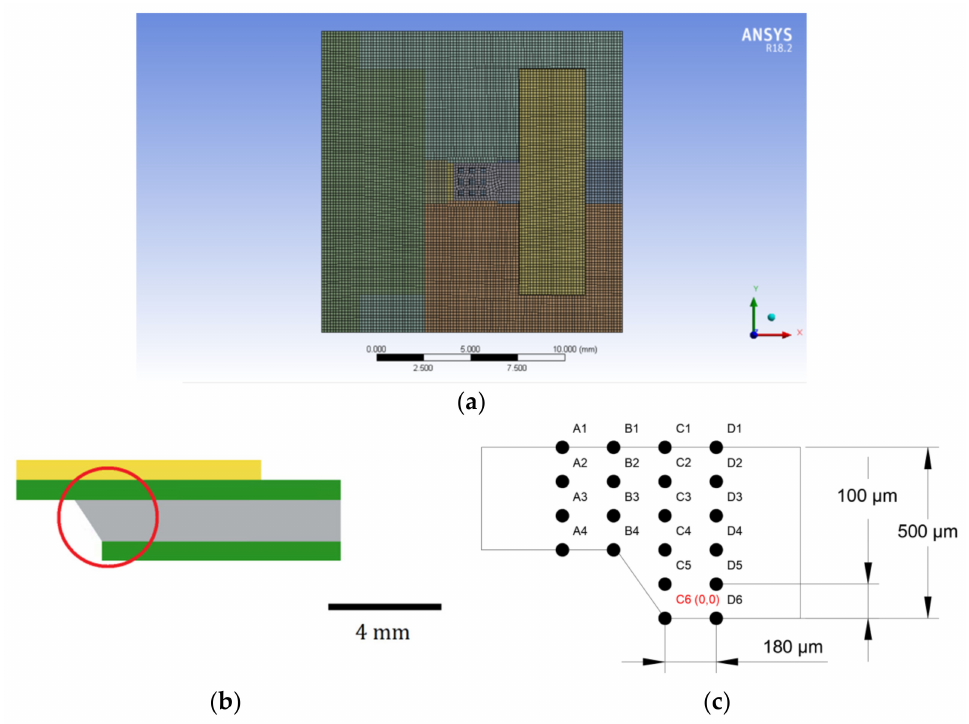
Figure 3. ( a ) Mesh, ( b ) location and ( c ) distribution of analyzed points in the simulation model of suspended sensing